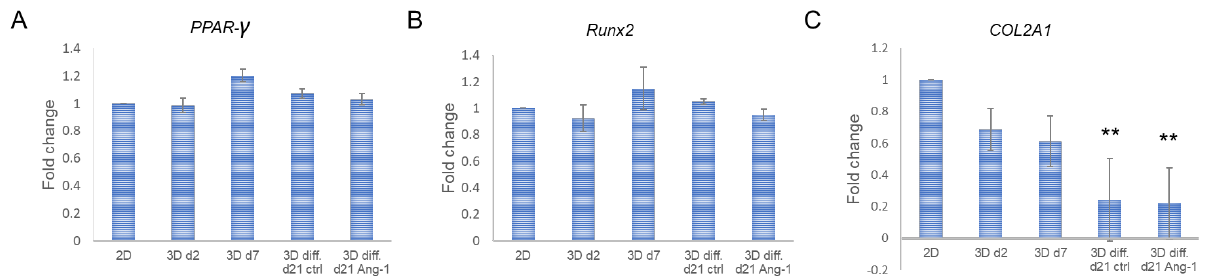
Figure 5. Quantitative real-time PCR of hASC-specific differentiation markers. A-C) Relative expression of adipogenic PPAR- γ ( A ), osteogenic Runx2 ( B ), and chondrogenic COL2A1 ( C ). ** p < 0.01 vs. 2D. N = 2 – 3 (3 technical replicates).